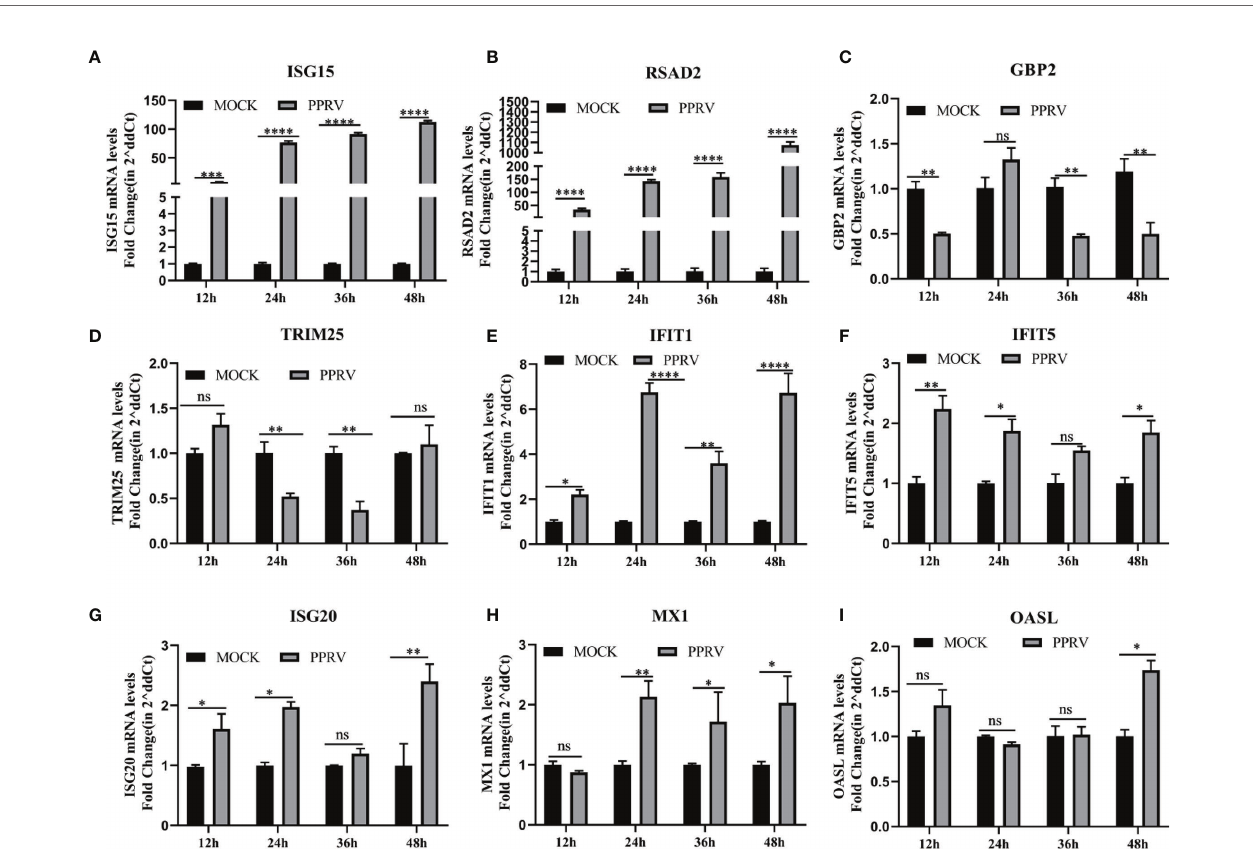
FIGURE 4 | PPRV induced upregulation of RSAD2 and ISG15 on EEC cells. (A – I) EECs were infected with PPRV for 12-48 h, and expression of ISG15 , RSAD2 , GBP2 , TRIM25 , IFIT1 , IFIT5 , ISG20 , MX1 and OASL was measured by RT-PCR. Comparisons between groups were calculated using two-way ANOVA in GraphPad Prism 8. * P < 0.05; ** P < 0.01; *** P < 0.001; **** P < 0.0001; ns, no signi fi cant